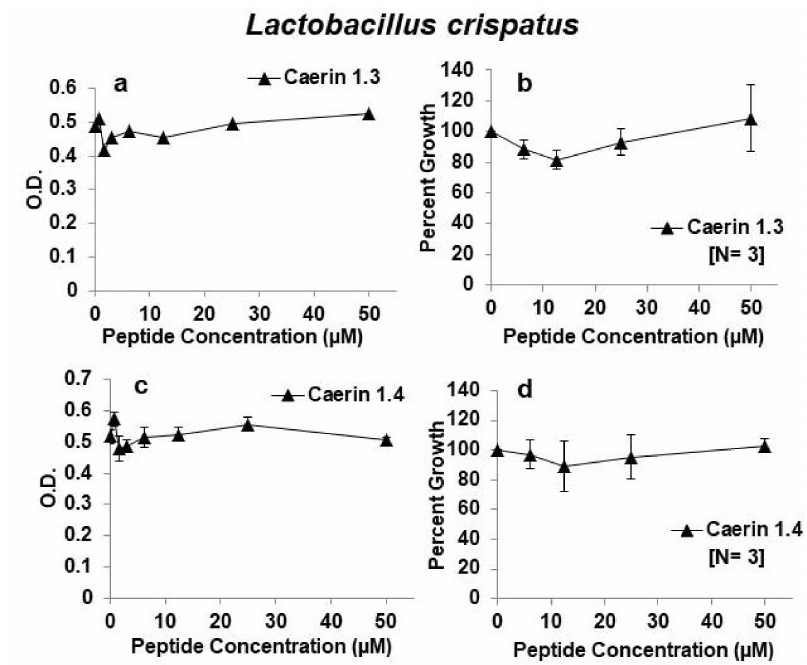
Figure 4. E ff ects of caerin 1 peptides on growth of Lactobacillus crispatus . ( a , b ) caerin 1.3; ( c , d ) caerin 1.4. Panels on the left show growth as changes in optical density (O.D.) at 630 nm for one representative experiment testing the peptides at increasing 2-fold concentrations from 0.4 or 0.8 to 50 µ M. Panels on the right show the average as percent growth in comparison with the positive (no peptide) control set at 100% for replicate experiments for the range of concentrations from 6.25–50 µ M. The number of replicate experiments for each peptide is shown in brackets within the